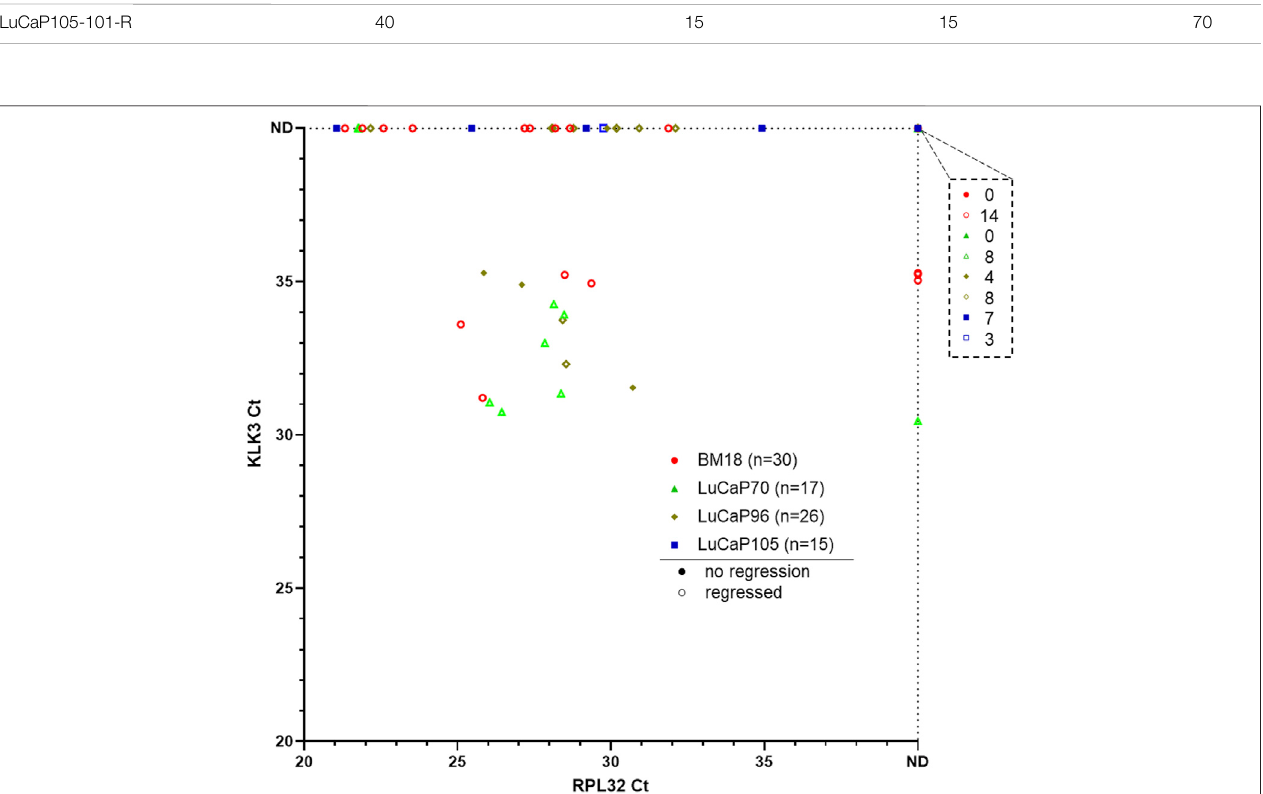
FIGURE 3 | Gene expression results for pre-screen of blood collected from prostate cancer PDX-bearing castrated mice. Raw Ct values for RPL32 and KLK3 genesfromfourPDXmodelsareplotted,withsmallervaluesrepresentinghighergeneexpressionandeachsymbolcorrespondingtoabloodsample.13/30BM18,8/17 LuCaP70, 14/26LuCaP96 and 5/15 LuCaP105 wereRPL32 positive.Foursamplesshowed expression ofKLK3 intheabsenceofRPL32. Thenumberofsamplesthat were negative for both RPL32 and KLK3 is indicated in the top right breakout box. Each point denotes a sample and hollow points represent samples from mice with regressed tumours. ND, not